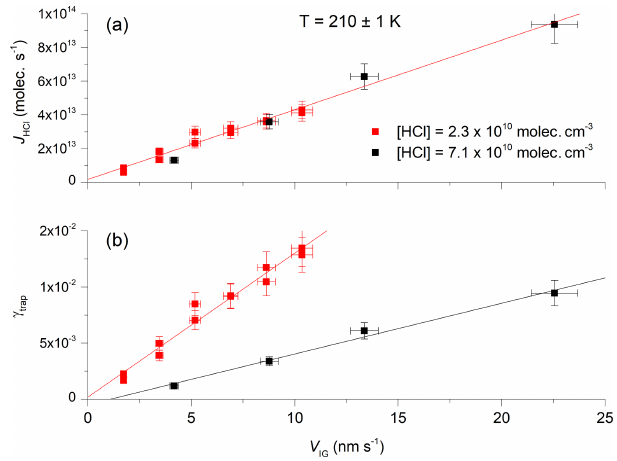
Figure 3. The trapping coefficient ( γ trap ) as a function of ice growth velocity at 210K using two different concentrations of HCl. The solid, straight lines are least-squares fits to the data. The error bars represent total uncertainty in γ trap and the ice growth velocity.